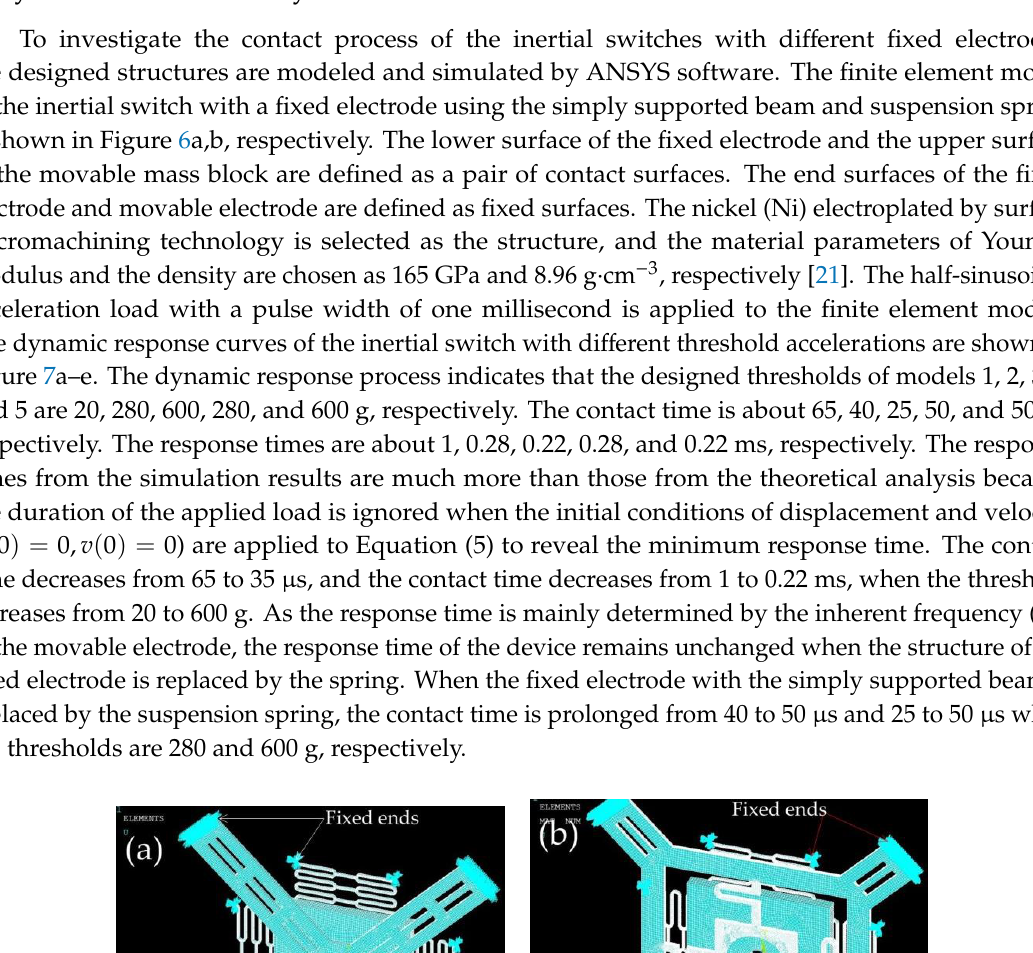
Figure 5. Contact process of inertial switch with spring-connected cross beam. ( a ) the acceleration is applied to inertial switch with fixed electrode of spring, ( b ) the fixed electrode of spring has elastic deformation due to the inertia impact of movable electrode, ( c ) the movable electrode returns to its original position.